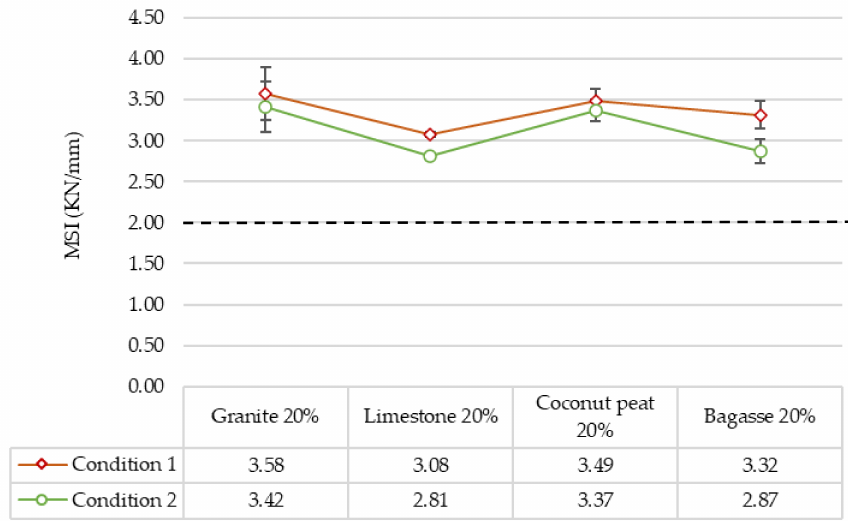
Figure 6. Marshall Sti ff ness Index of asphalt